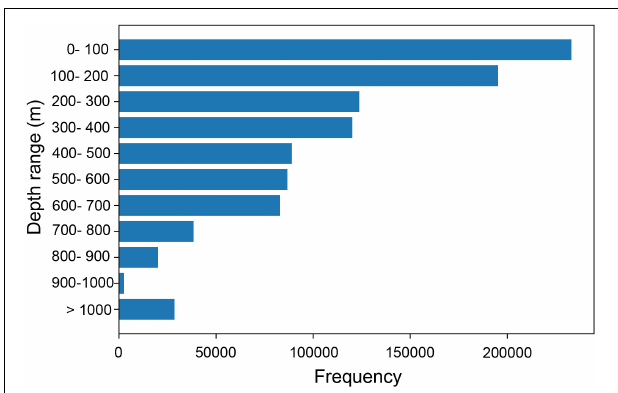
FIGURE 2 | Frequency distribution of the AQC-Argo data in the Japan Sea with respect to the